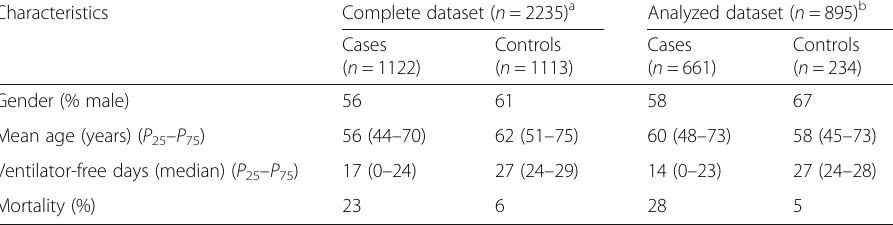
ARDS acute respiratory distress syndrome, P 25 percentile 25, P 75 percentile 75 a Total number of individuals included in the GWAS study by the ARDSnet and the iSPAAR Consortium (ARDS cases and at-risk controls) according to dbGaP study phs000631.v1.p1 b Subset of individuals selected to perform the association study (septic-induced ARDS cases and non-septic and non-ARDS